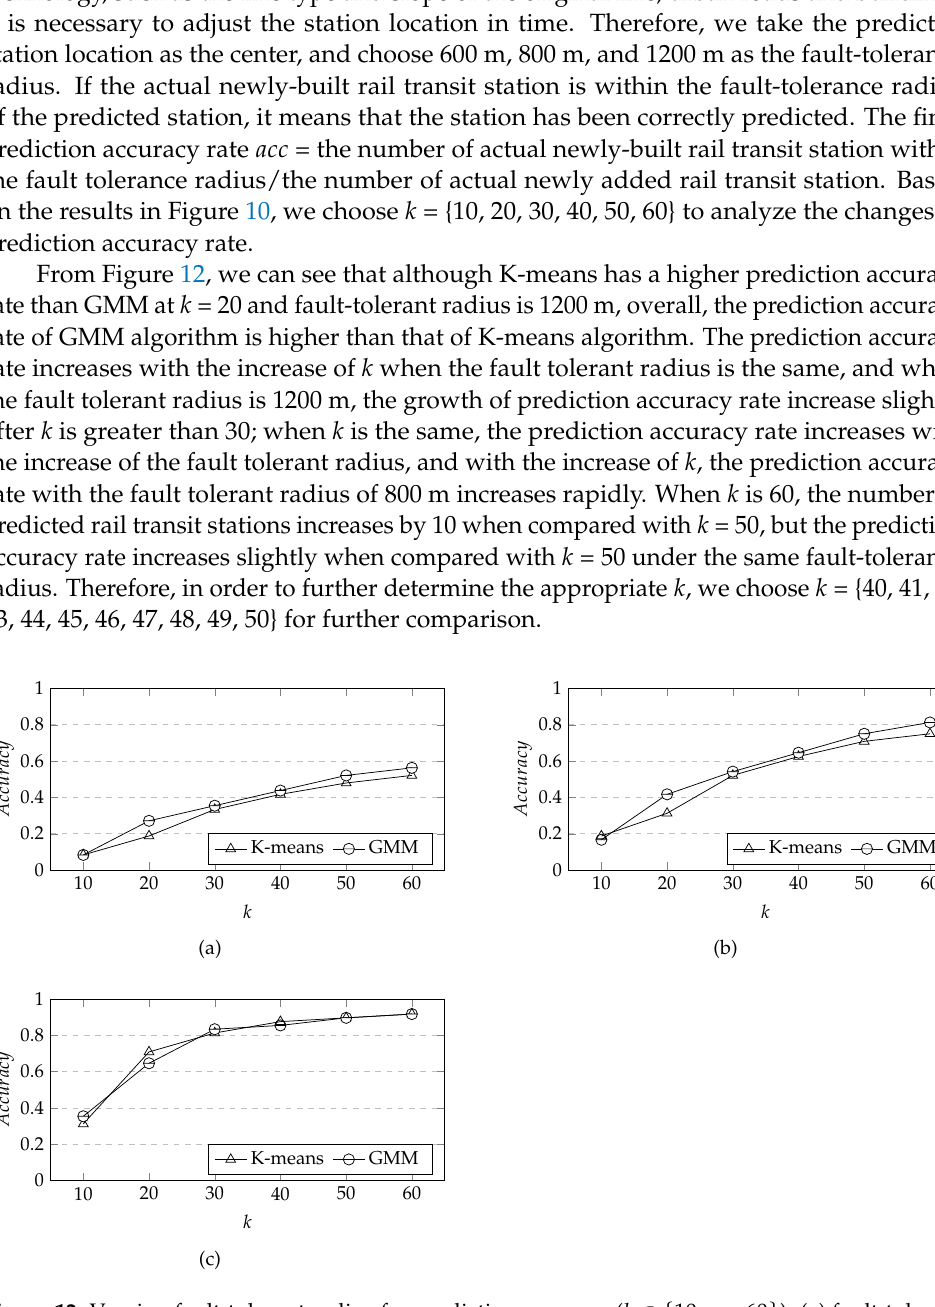
Figure 12. Varying fault-tolerant radius for prediction accuracy ( k ∈ { 10, . . . ,60 } ). ( a ) fault-tolerant radius = 600 m; ( b ) fault-tolerant radius = 800 m; ( c ) fault-tolerant radius = 1200